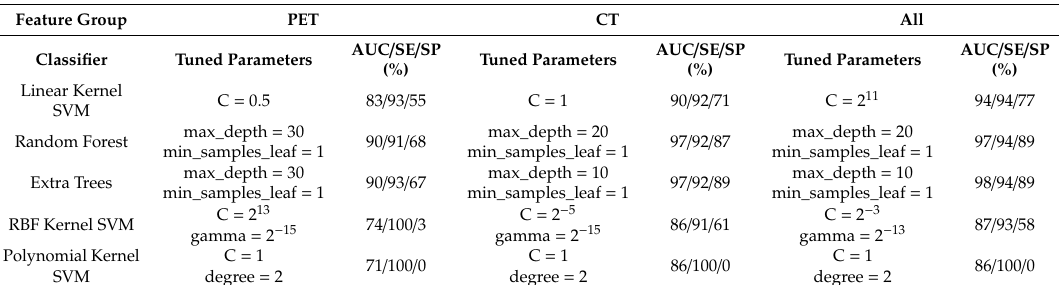
Figure 3. Results of final validation step: ROC curves for five ML algorithms to predict pathological vs. non-pathological hotspots on the validation set using PET ( A ), CT ( B ), and all features ( C ). AUCs, sensitivities, and specificities are shown for each ML method applied to each feature group. Table 4. Tuned parameters and accuracy measures (area under the curve (AUC), sensitivity (SE), and specificity (SP)) obtained for ML classifiers applied to different feature groups. The classifiers were trained by the cohort containing 48 subjects and tested on the hold-out set with 24 subjects.